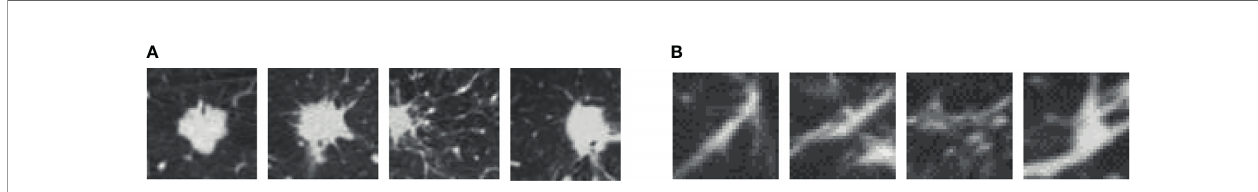
FIGURE 2 | Nodules and suspected nodules in pulmonary CT images; (A) Nodules; (B)